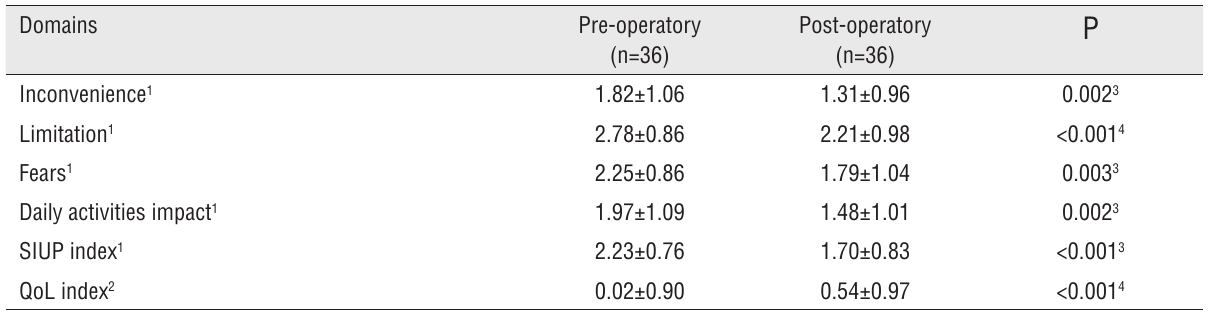
Table 2 - Quality of life before and after surgery according to Qualiveen ® questionnaire.